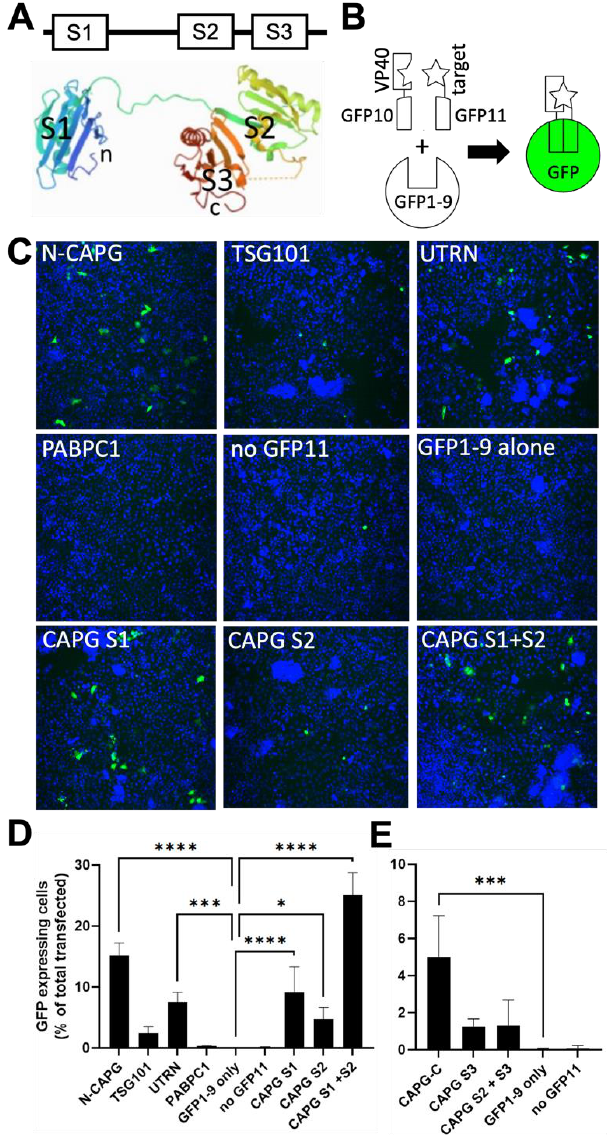
Figure 5. Identification of CAPG subdomains important for interaction with VP40. ( A ) Schematic representation of the CAPG protein. Each gelsolin domain is indicated by S1, S2 and S3. The 3D structure of CAPG is shown and was derived from PDB 1JHW. ( B ) Shows the arrangement of the tripartite split GFP system. For this assay, the GFP10 peptide was used to tag VP40 and the GFP11 peptide was used for the indicated host cell protein targets. When each part is brought together with the remainder, GFP1-9, cells fluoresce green through formation of mature GFP. ( C ) Represen- tative images showing cell nuclei stained with Hoechst 33342 (blue) and GFP positive cells (green), representing reconstituted GFP, for the indicated host protein tagged to GFP11 peptide and VP40 tagged to the GFP10 peptide. ( D ) Quantitation of image sets for N-terminus tagged proteins with GFP11. Sets of 4 wells were transfected with each tagged construct and GFP1-9 expression plasmid that also encoded mCherry as a marker of transfection efficiency. The number of GFP-expressing cells was counted using CellProfiler and expressed as the fraction of transfected cells. ( E ) Quantitation of image sets for C-terminus tagged domains. The S3 domain of CAPG was expressed as a C-terminal fusion with GFP11. Despite lower efficiency of mature GFP formation, significant activity allowed comparison to full length CAPG. Mean ± SD are shown with *, p < 0.05; ***, p < 0.001; ****, p < 0.0001 by One-way ANOVA with Dunnet’s multiple comparisons